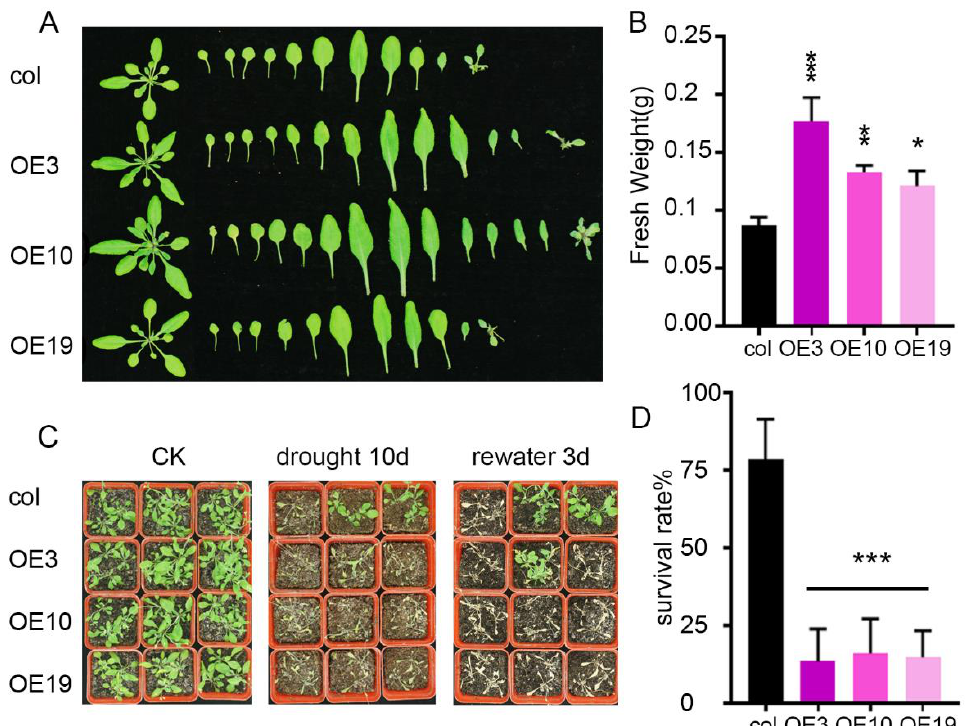
Figure 5. Phenotype and survival rate of ZmLBD5 transgenic seedlings under normal or drought conditions in soil: ( A , B ) Phenotype and fresh weight of ZmLBD5 transgenic seedlings under normal conditions in soil. ( C , D ) Survival rate of ZmLBD5 transgenic seedlings under drought conditions in soil. Significance was analyzed by one-way ANOVA. * p < 0.05; ** p < 0.01; *** p < 0.001. All bars represent means ± SD ( n ≥ 12).